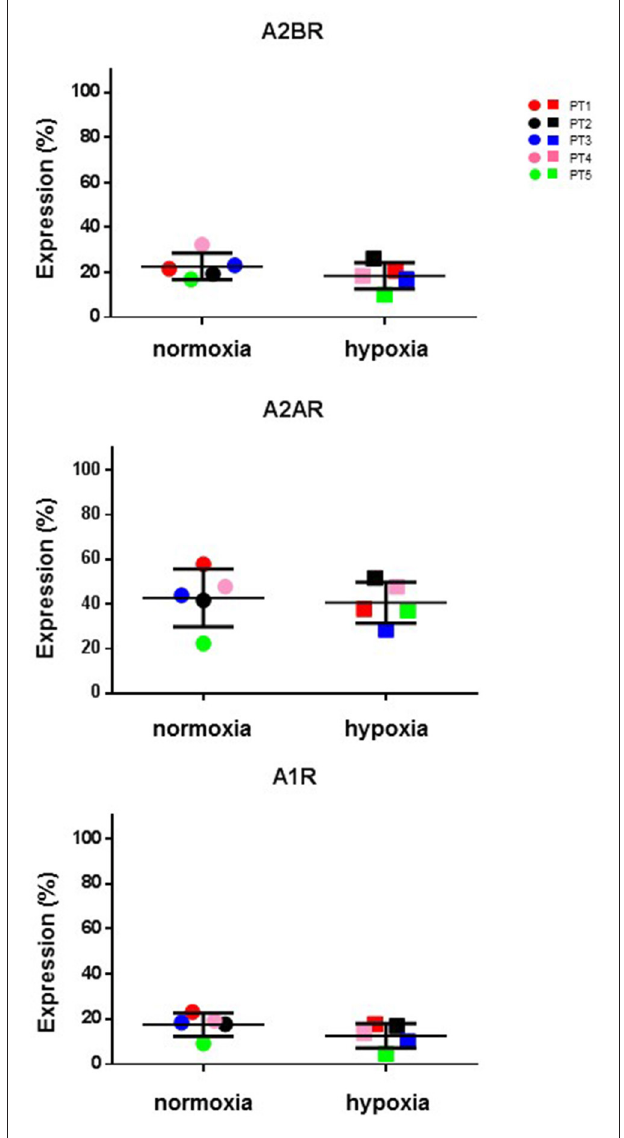
FIGURE 7 | Expression of P1 receptors in normal and hypoxic conditions. Comparative cytofluorometric analysis of A 1 R, A 2A R and A 2B R expression in CIK cells stained with primary antibodies to various P1 receptors and detected with fluorescein (FITC)-conjugated secondary antibodies as reported in Materials and Methods. To compare data obtained in hypoxia and normoxia we used unpaired nonparametric test, two-tailed Mann-Whitney for GraphPad Prism 6. Circles, normoxia; squares, hypoxia. Patients are as following: PT1, red; PT2, black; PT3, blue; PT4, pink; PT5, green. Reported data are expressed as mean values ±